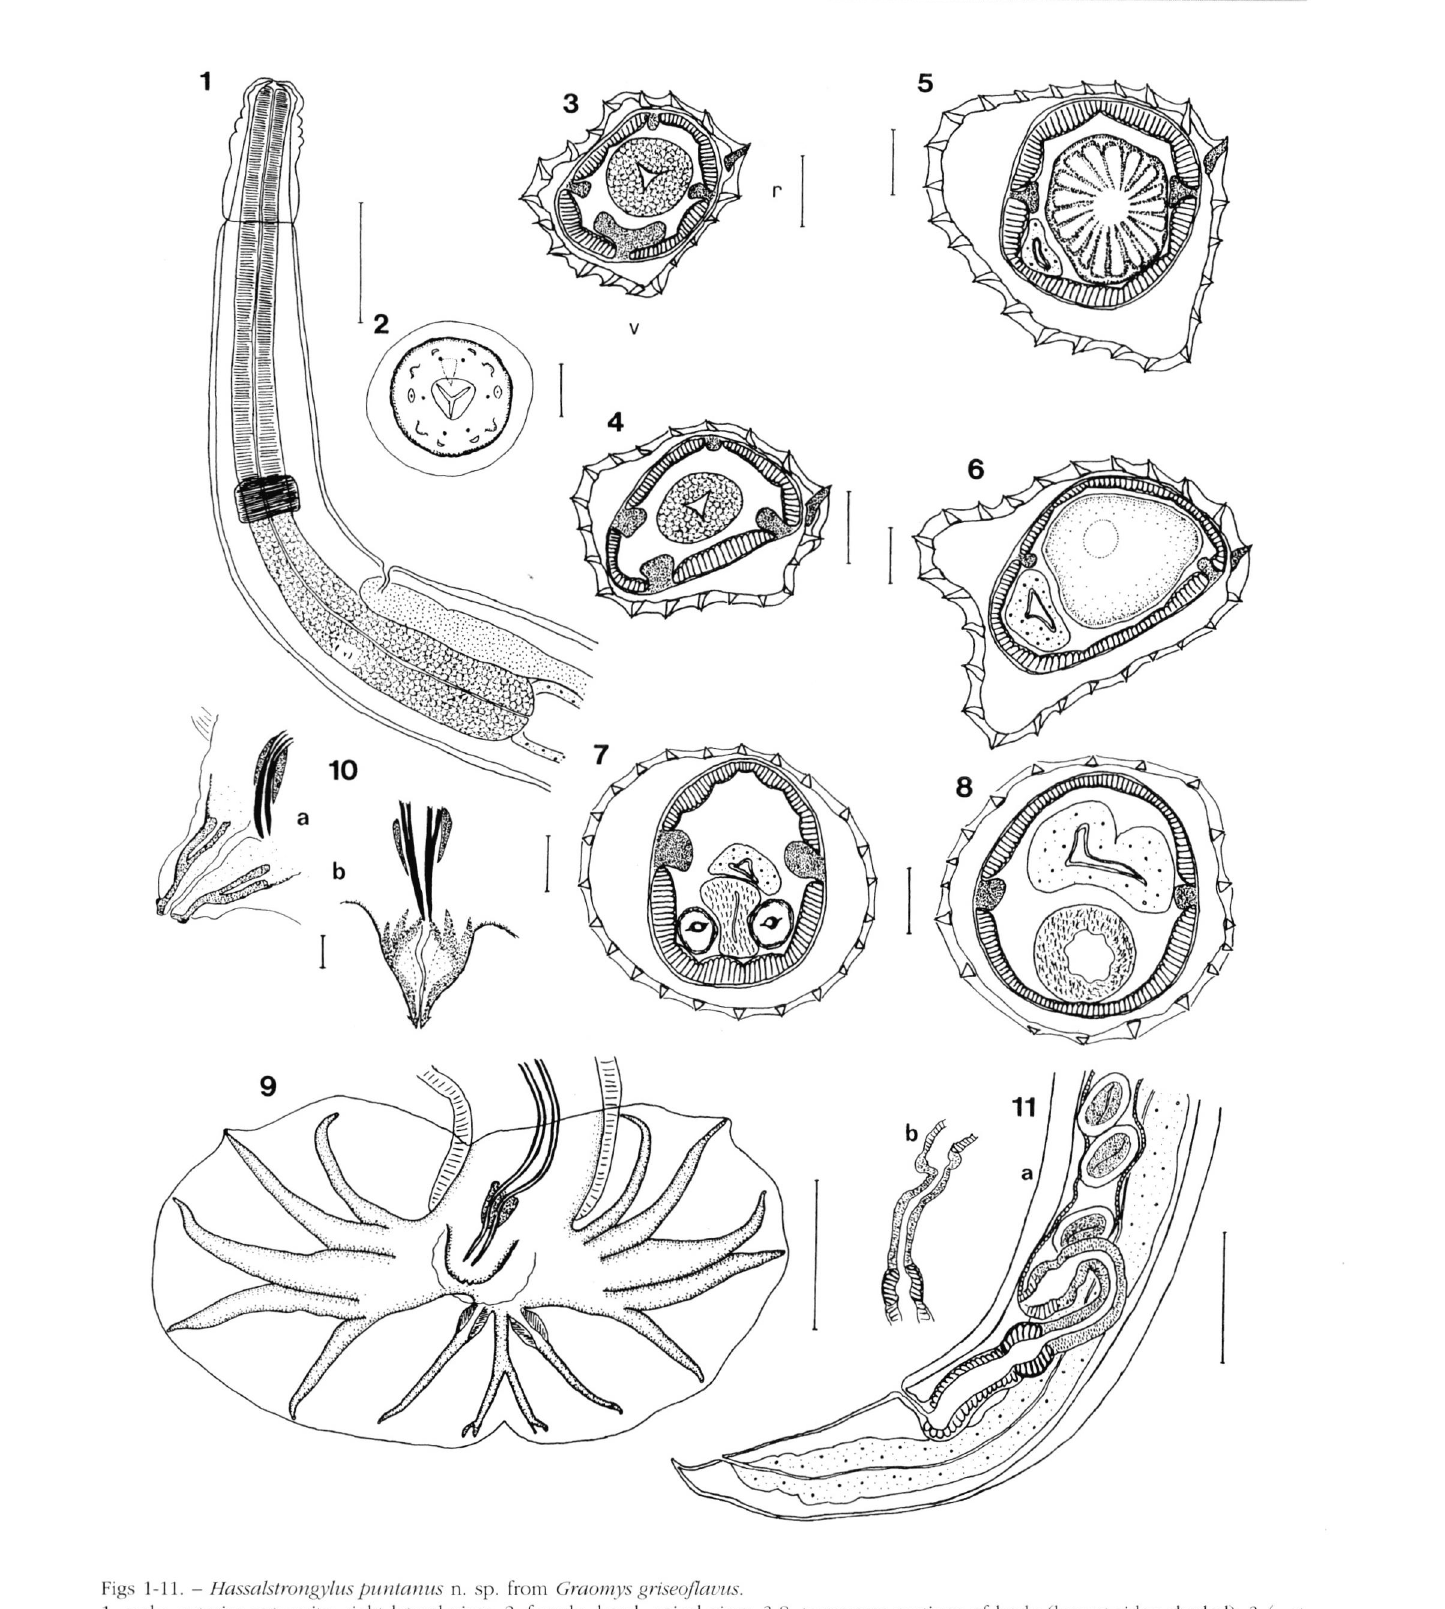
Parasite. 2003, 10,